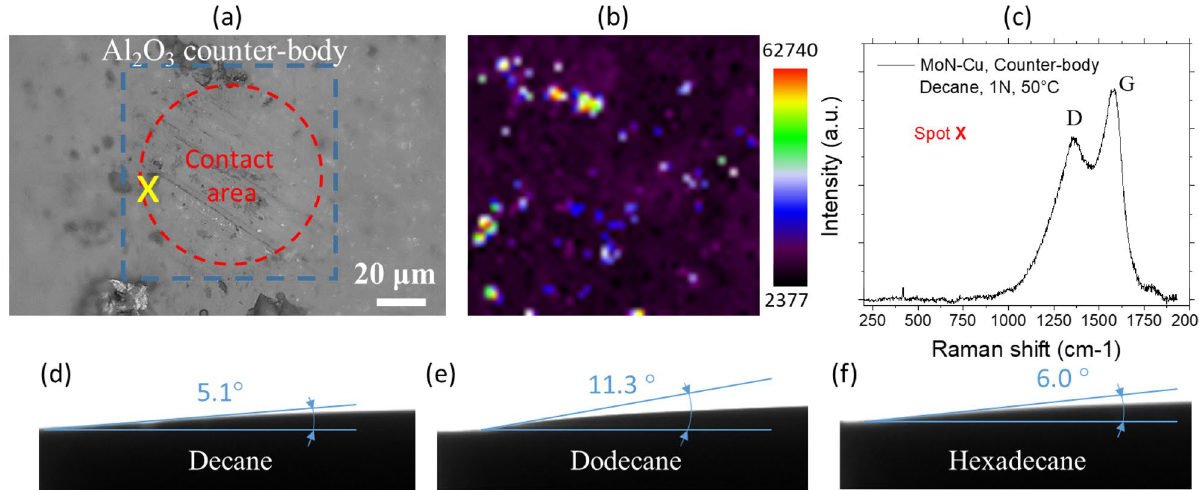
Figure 6. ( a ) Counter-body’s optical micrograph showing the contact area formed on the alumina ball with blue dashed line highlighting the area of interest for the 2D-Raman analysis, ( b ) 2D Raman map of carbon G-band, and ( c ) single Raman spectrum acquired from spot “X” that shows the DLC film transfer on the counter-body. The wetting angle measurements on MoN-Cu surface for ( d ) decane, ( e ) dodecane, and ( f ) hexadecane